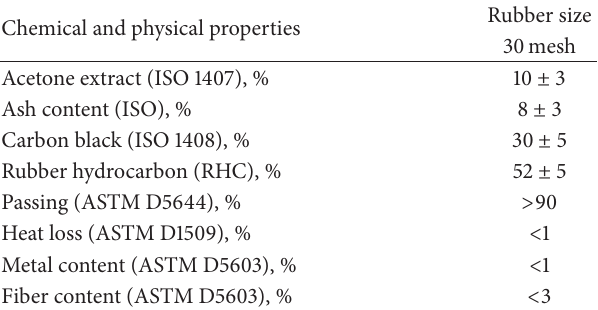
Table 3: Specification of crumb rubber used in this study.